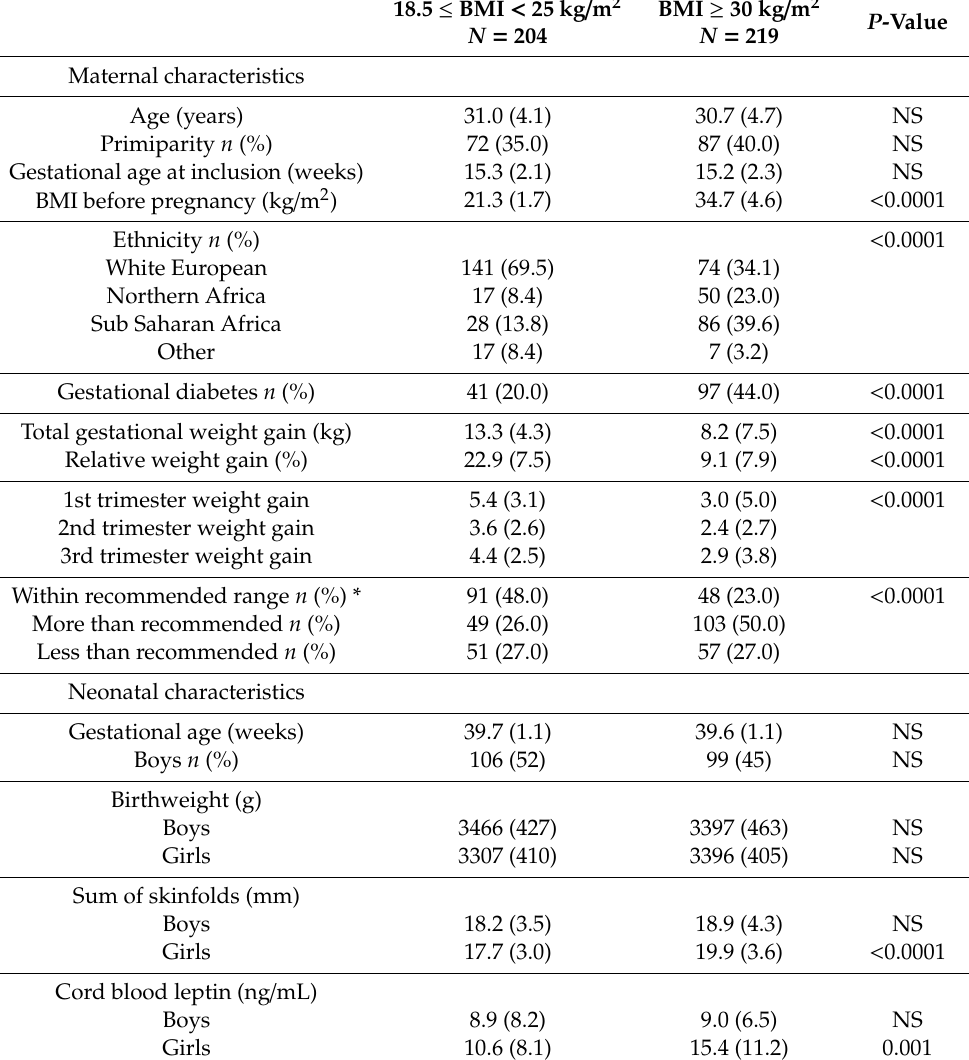
Table 1. Maternal and neonatal characteristics according to maternal BMI. Data are expressed as mean (SD) or N (%). * according to the Institute of Medicine (IOM) recommendations. BMI: Body Mass Index; NS: not